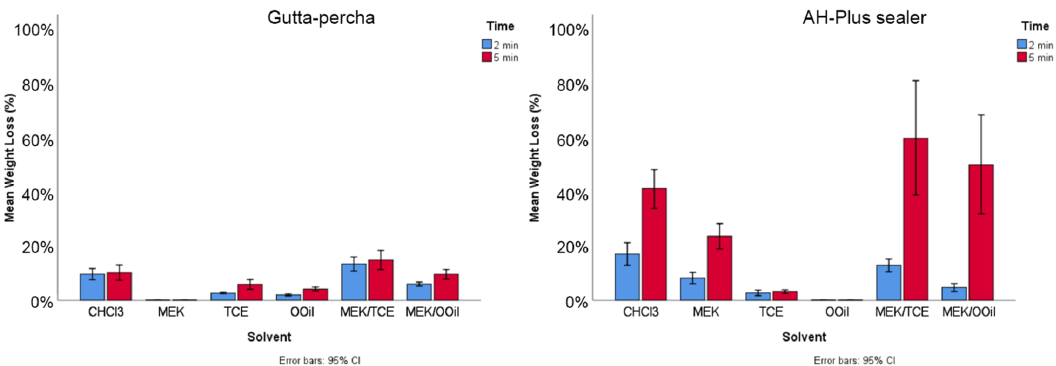
Figure 2. The weight loss of the gutta-percha and AH Plus samples after immersion in the tested solutions for 2 and 5 min—CHCl 3 , chloroform; MEK, methyl ethyl ketone; TCE, tetrachloroethylene; OOil, orange oil. Mixtures: MEK / TCE; MEK /